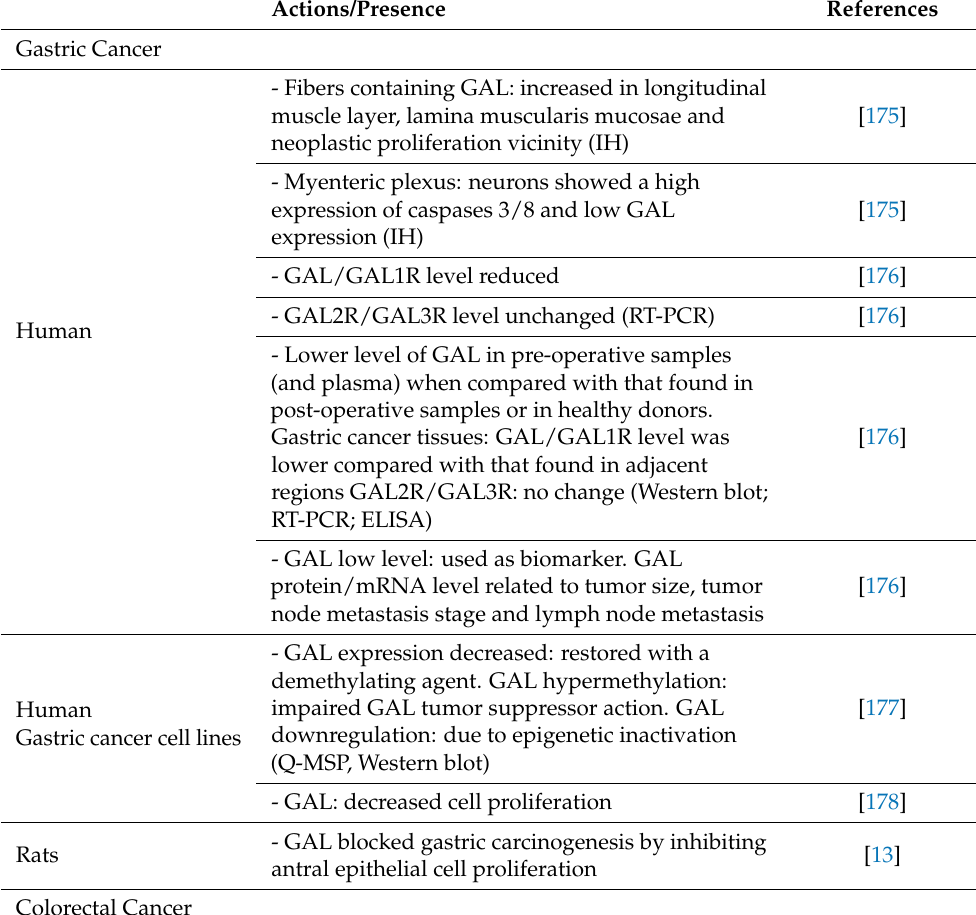
Table 2. Involvement of the galaninergic system in gastric and colorectal